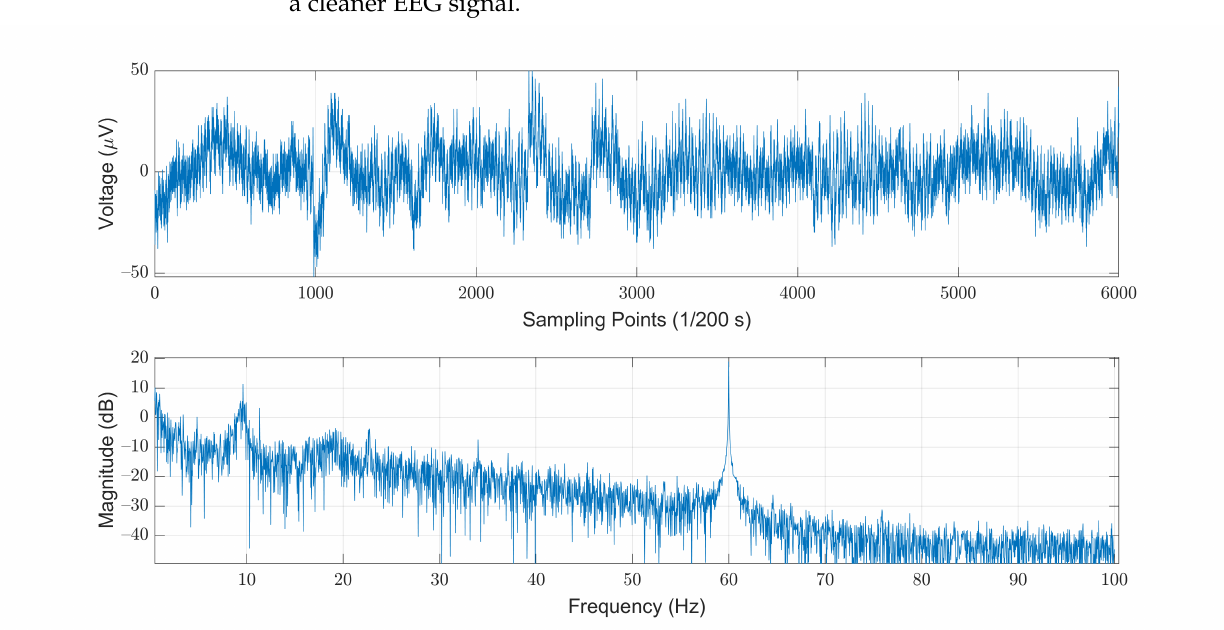
Figure 2. An example of the original EEG signals illustrated in time ( top ) and frequency ( bottom )